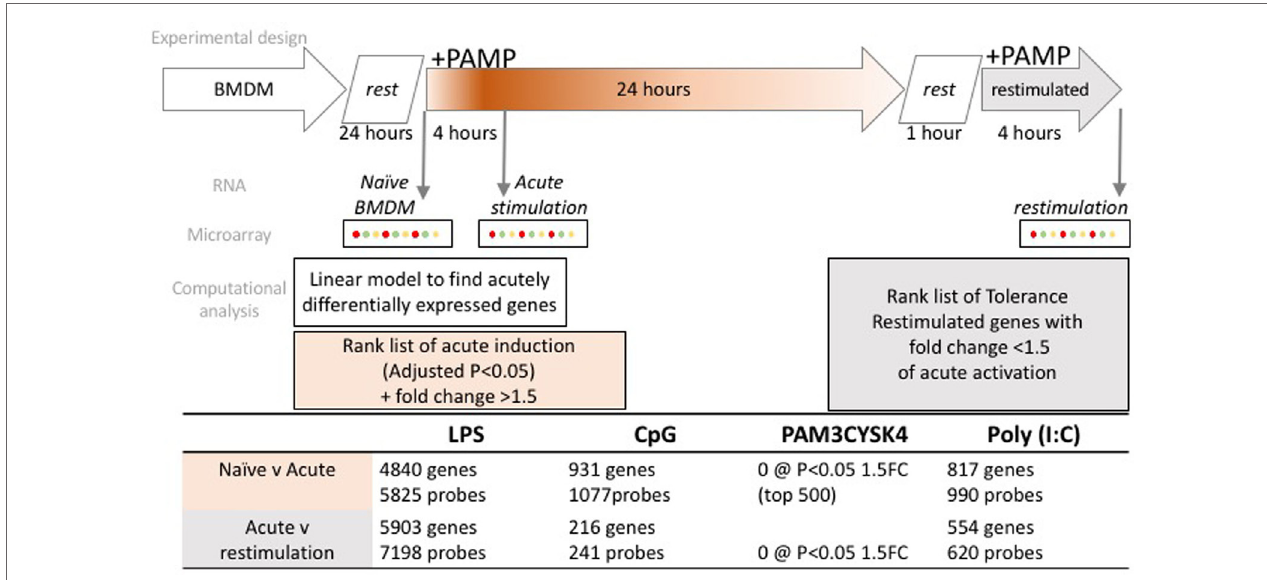
FigUre 1 | Experimental overview and workflow for transcriptome data normalization, filtering, and analysis. Bone marrow derived macrophages (BMDM) were differentiated for 7 days in L-cell conditioned media, washed and rested for 24 h, prior to acute stimulation with one of four toll-like receptor ligands. Cells were washed after 24 h, rested for 1 h, prior to restimulation with the same ligand. RNA was collected as indicated, from naïve, 4 h (acute) and 4 h (restimulated) time points. Microarray profiling followed, with the numbers of microarray probes, and correspondingly annotated genes that met the criteria for acute induction, or tolerance, as indicated in the